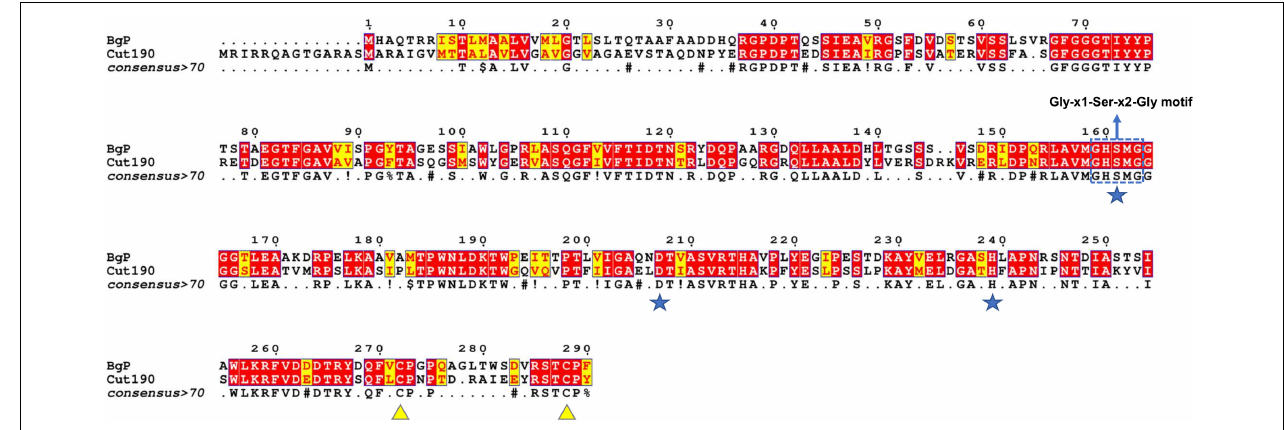
FIGURE 2 | Amino acid sequence structural alignment of BgP and Cut190 generated with T-COFFEE Expresso and rendered using ESPript 3.0. Cut190 was indicated as a suitable structural homolog for BgP by the Phyre2 server. Amino acid residues shaded in red represent the ones strictly conserved between BgP and Cut190, while residues highlighted in yellow depict areas with an average level of homology. Catalytic triad residues are marked with a blue star, and disulfide bond cysteines are marked with a yellow triangle. The pentapeptide Gly-x1-Ser-x2-Gly serine hydrolase motif is outlined with a blue box.